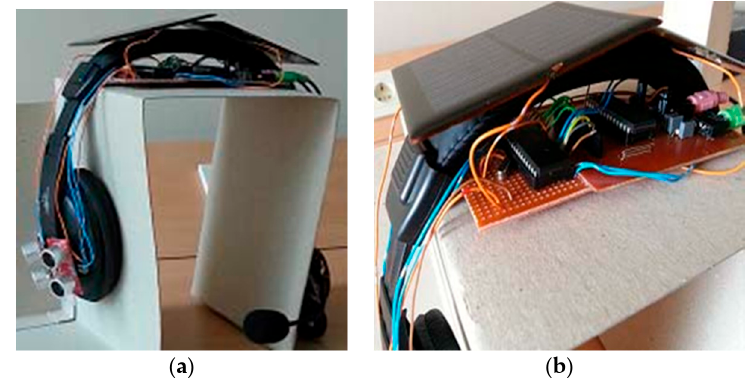
Figure 35. ( a , b ) Display the proposed ultrasonic headset with illustrating of the circuit and the solar panels [55].